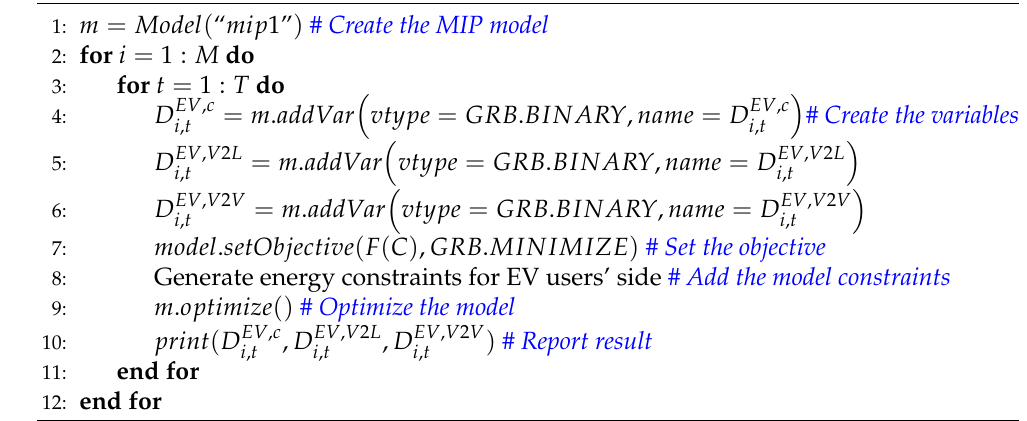
Algorithm 1 Workflow of MIP model for EV scheduling